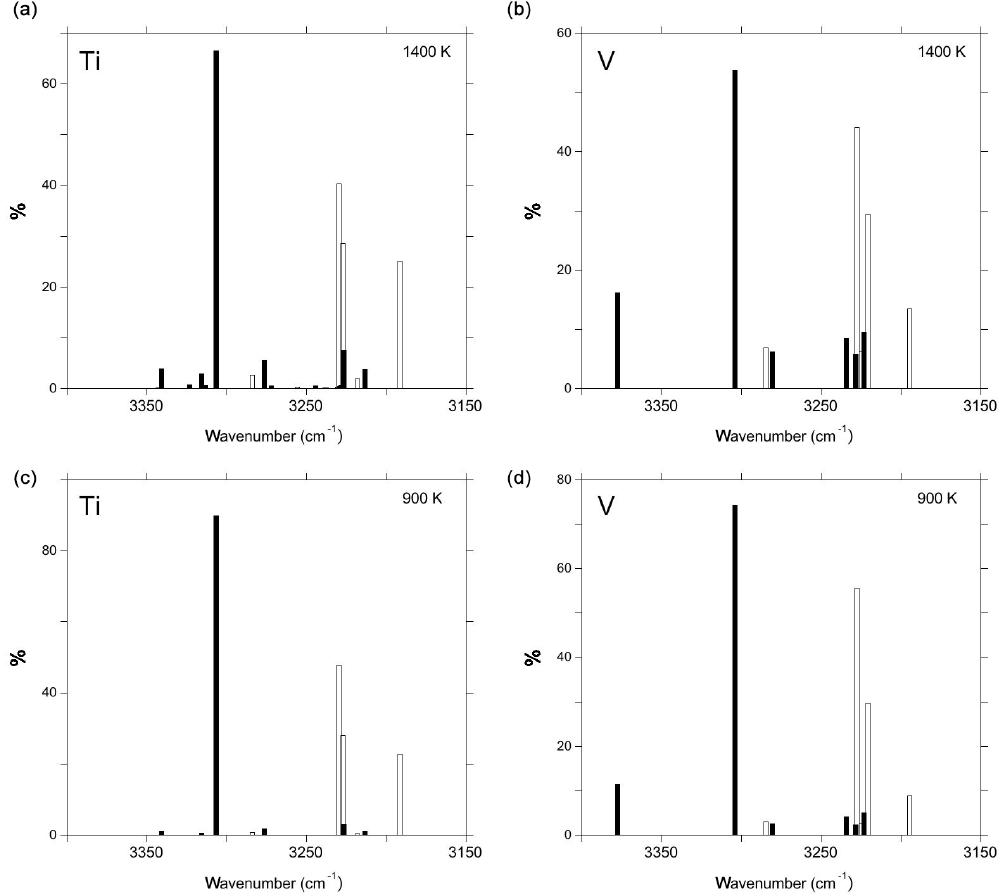
Figure 6. Configuration distributions of Ti-associated defects (a, c) and V-associated defects (b, d) at temperatures of 900K (a, b) and 1400K (c, d) . The open and full bars correspond to defect models displaying one or two cationic substitutions, respectively. The theoretical frequencies have been lowered by 125cm − 1 to facilitate the comparison with experimental spectra. Note that the clustering equilibrium describing the relative contributions of models displaying one or two cationic substitutions is not considered in these